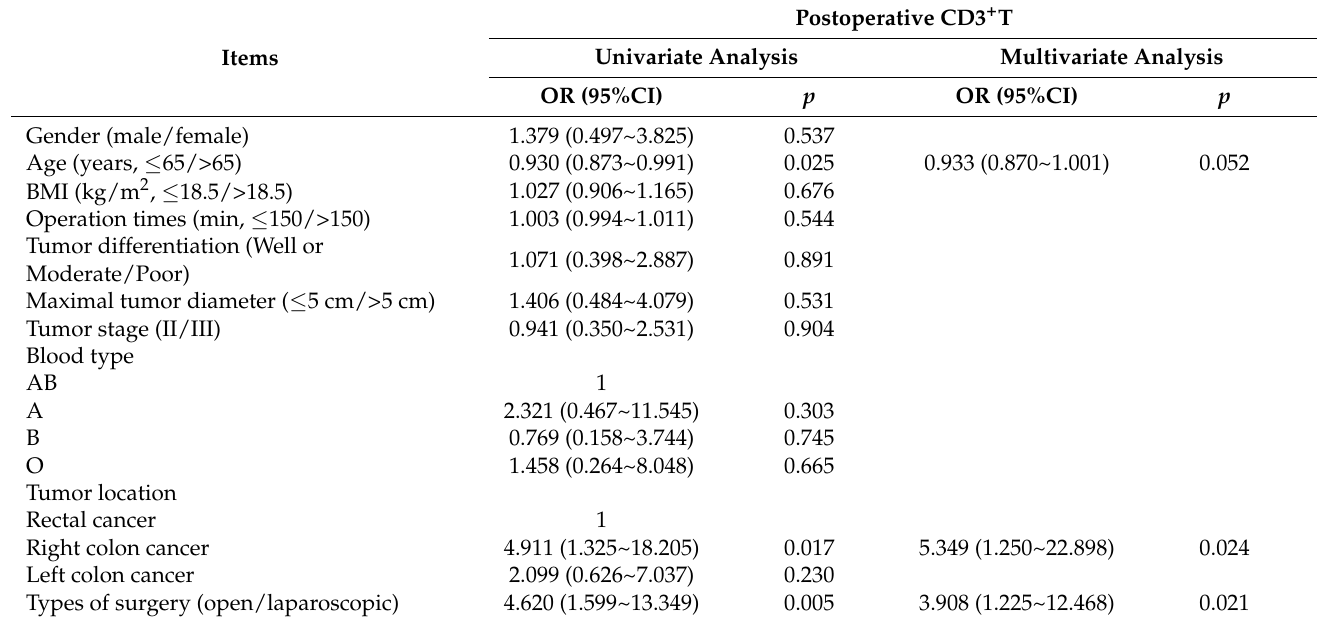
Table 3. Logistic regression analysis of the patient’s postoperative CD3 +